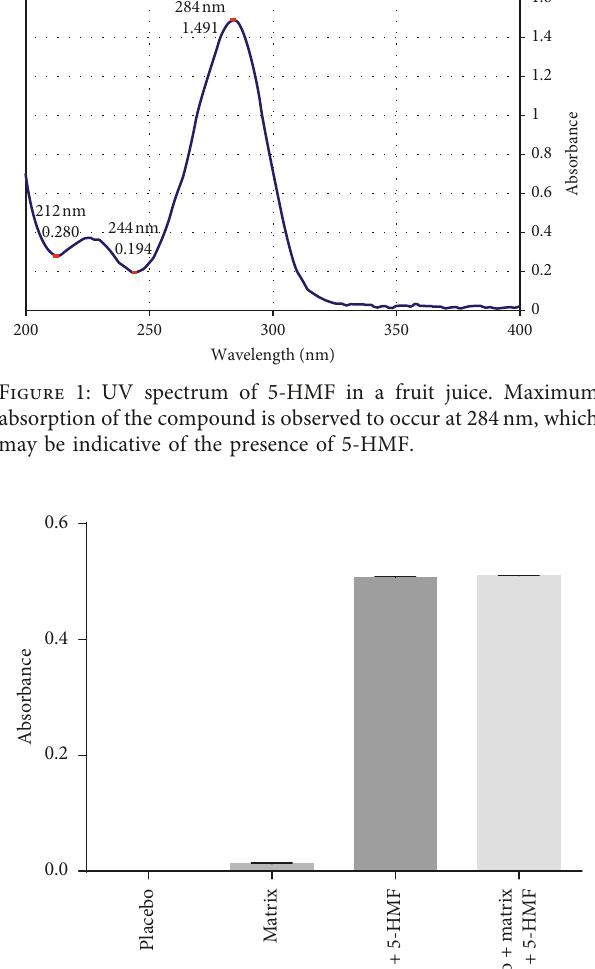
Table 2: Results from regression analysis in the linearity test.